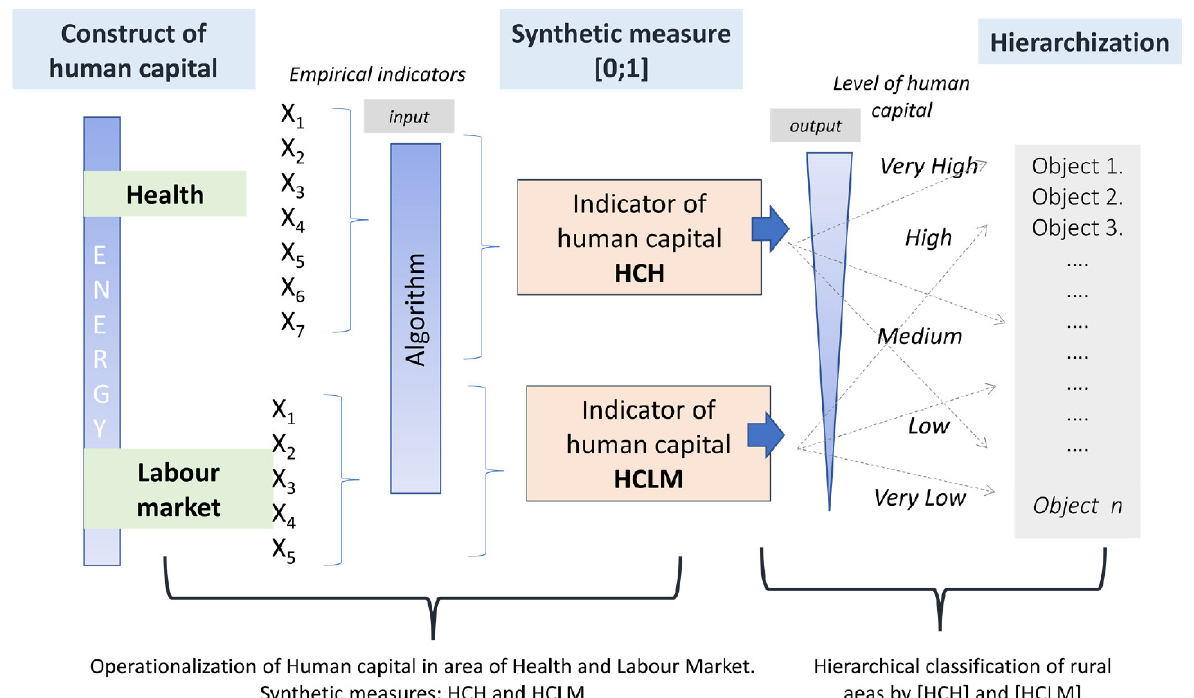
Figure 2. Diagram of human capital operationalization in area of health and labor market and the hierarchical classification of rural areas according to the level of human capital in area of health (HCH) and labor market (HCLM). Study procedure. Source: Own elaboration.